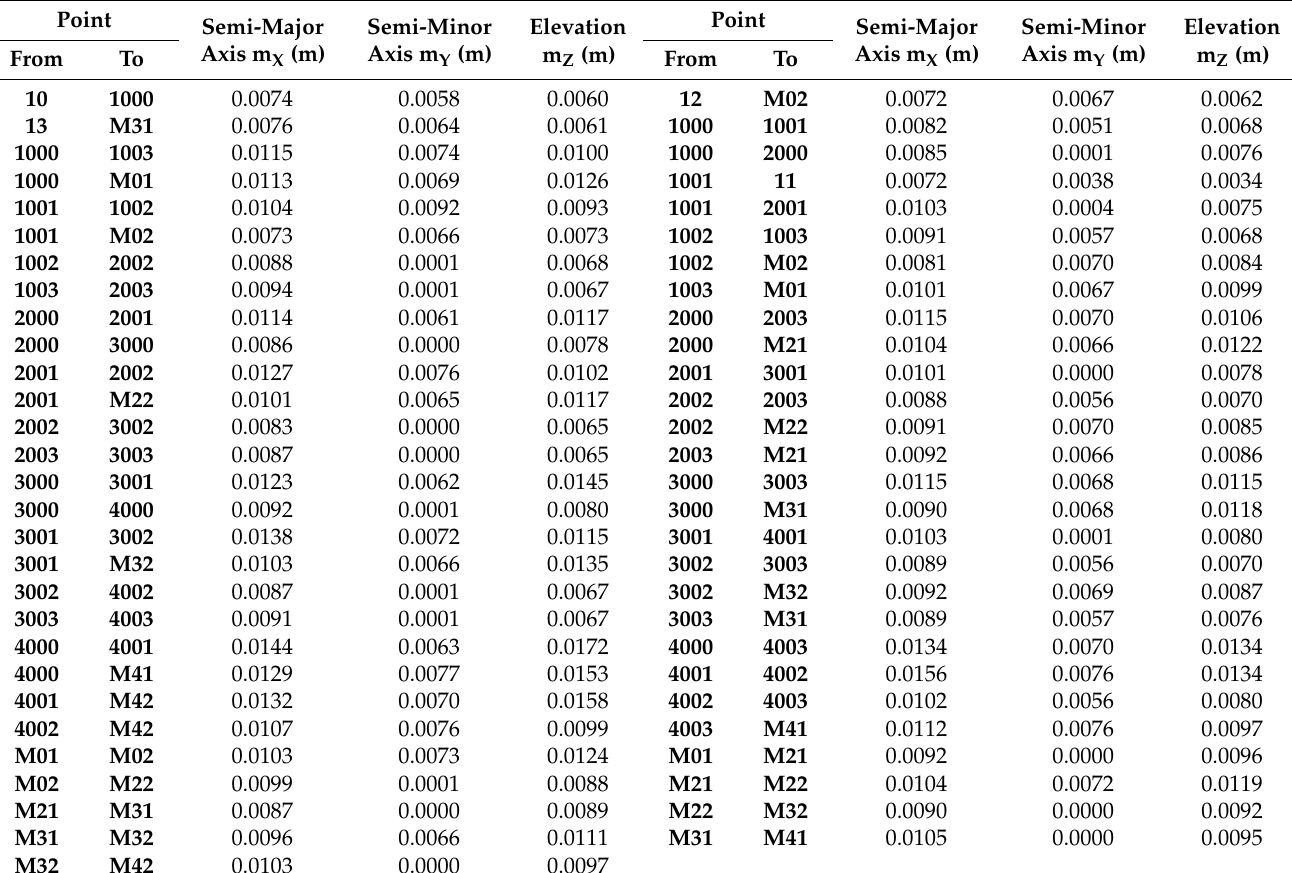
Table A2. The relative accuracy of the point coordinates (95% confidence level).